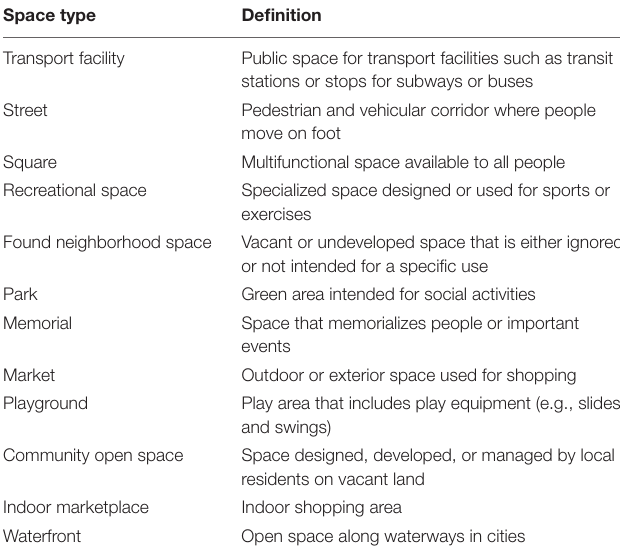
TABLE 1 | 12 Major types of public